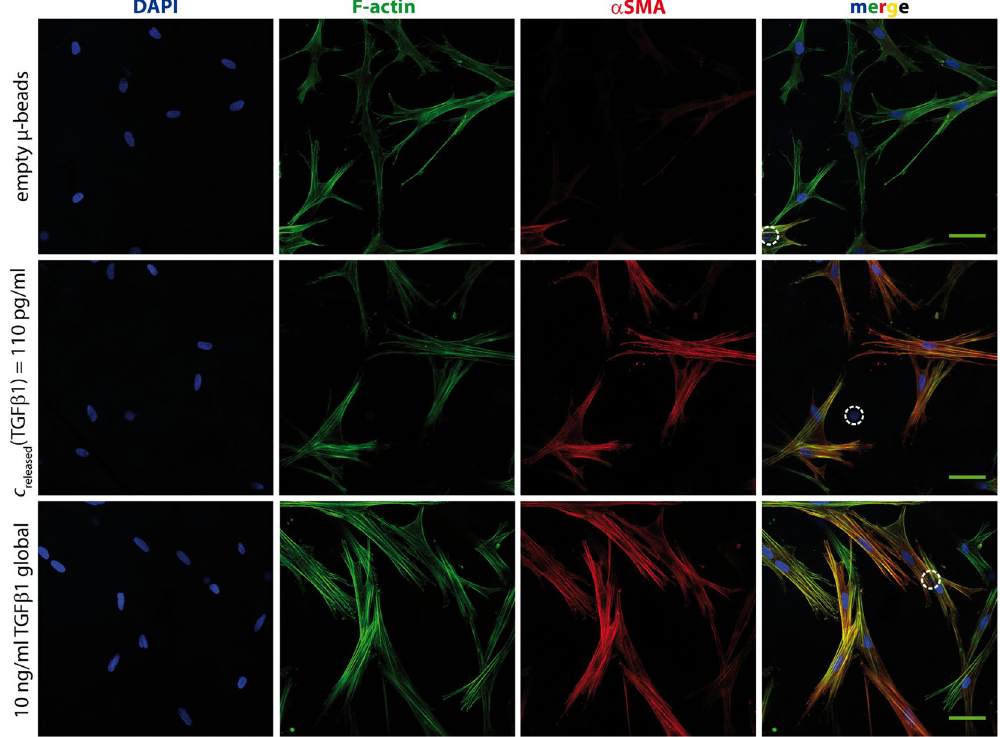
Figure 3. α SMA is expressed in actin stress fibers after stimulation with TGF β 1. Non-TGF β 1 stimulated fibroblasts (“empty beads”, upper row) exhibit phalloidin-stained stress fibers (green), but negligible staining of fibrillary α SMA (red). In comparison, TGF β 1 stimulated cells show α SMA staining in F-actin stress fibers. Colocalization of F-actin and α SMA is obvious in the merged images by yellow fibrillar structures. TGF β 1 delivery – whether 10 ng/ml systemic (lower row) or sustained local release of 110 pg/ml from µ -beads (middle row) – leads to comparable results. Scale bar: 50 µ m. White dashed circle in the merged images indicates µ -bead